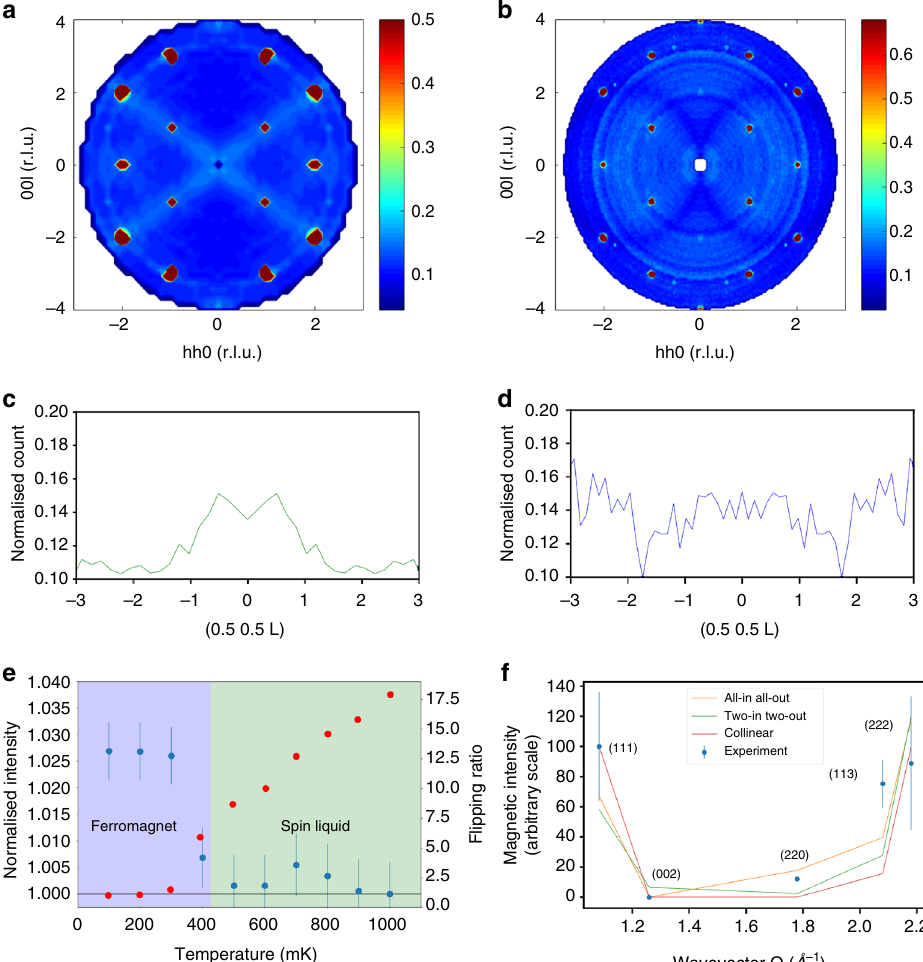
Fig. 3 Spin correlations in nominally stoichiometric Yb 2 Ti 2 O 7 . a The unpolarised neutron scattering from the as-grown sample measured at T ~ 50 mK in the ( hhl ) plane, showing the characteristic rods of intensity along <111> directions. b Measurements under identical conditions from the same sample after annealing in oxygen shows the complete elimination of diffuse magnetic scattering. 1D cuts along [0.5,0.5, l ] for c the as-grown and d the oxygen-annealed samples. The diffuse magnetic scattering from − 1 < L < 1 observed for the as-grown sample completely disappeared for the oxygen-annealed sample. a and b are plotted with different scale bars because of different background levels, see c and d , from different volumes of copper in the beam. The dips in the scattering at L = ±1.8 in d result from the grazing-incidence/grazing-exit absorption by the copper plate, see Supplementary Figure 2c. e Temperature dependence of the integrated intensities of the (113) Bragg re fl ection normalised to unity at T ~ 1 K (blue), and the fl ipping ratio measurements (red), show that the oxygen-annealed sample enters a ferromagnetic phase below T C ~ 425 mK. Error bars are the standard deviations derived using Poisson statistics. f Magnetic scattering intensities obtained by subtracting the integrated intensities at T ~ 1.2 K from those at T ~ 50 mK. The solid lines show the comparison with the data for the collinear ferromagnet 9 , the two-in two-out splayed ferromagnet 6 and the all-in all-out splayed ferromagnet 10 . The magnetic intensity at (220) rules out the collinear ferromagnet, and the absence of magnetic intensity at (002) is inconsistent with the ice-like splayed